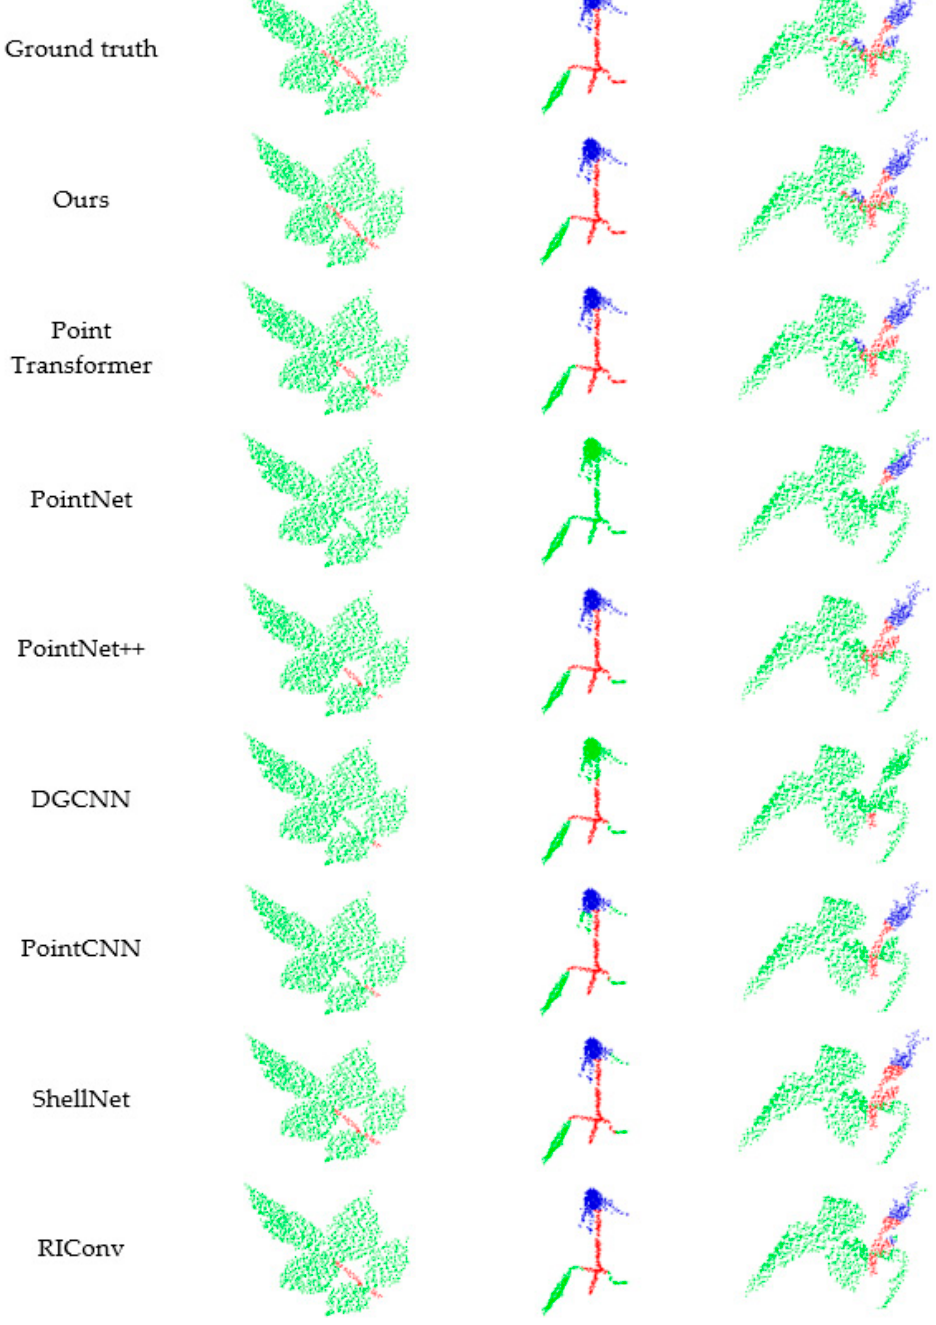
Figure 7. Segmentation rendering of different networks.